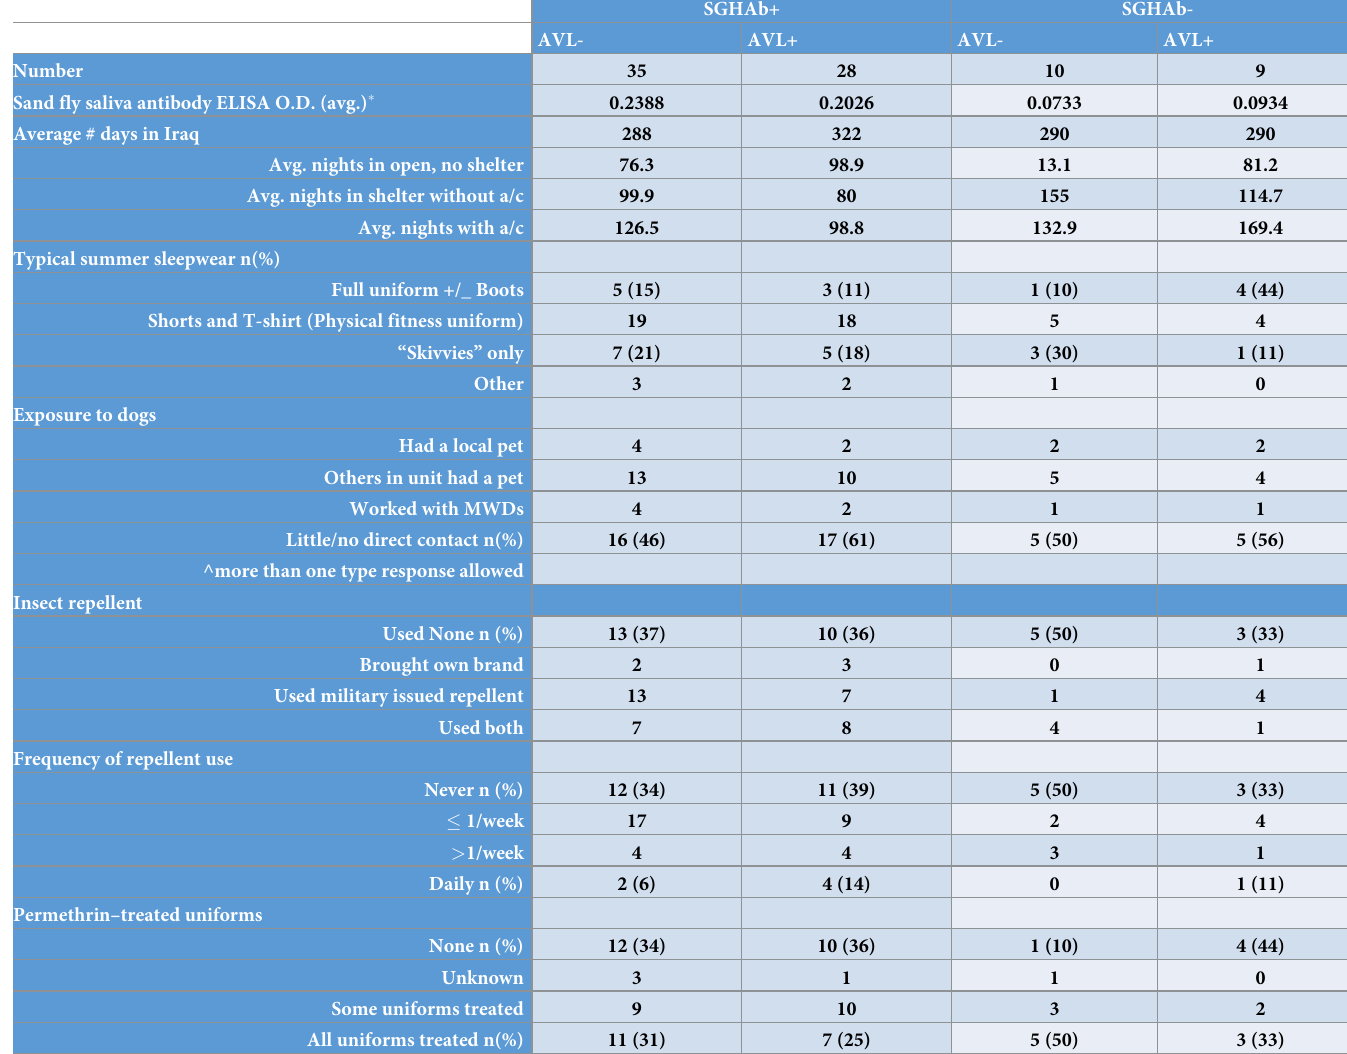
Table 3. Associations of Reported Sand Fly Exposure Risk Factors to SGH Antibody Levels and Diagnosis of Asymptomatic Visceral